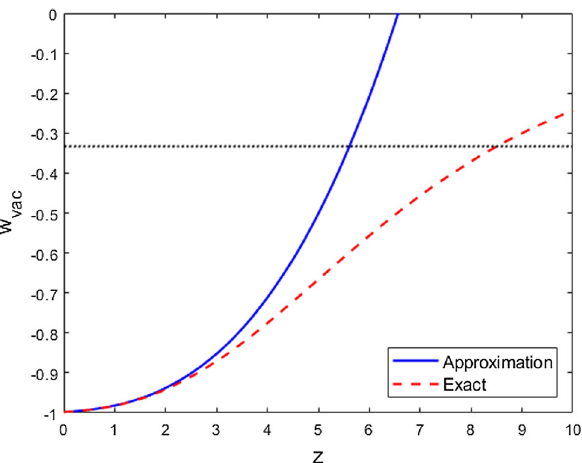
Fig. 3 Vacuum EoS at low redshifts including the quantum effects computed in this work. The horitzontal (dotted) line, marks the constant EoS value − 1/3, below which a fluid contributes to the accelerated expansion. We show both the curve corresponding to the approximate formula (8.16) and the exact curve computed numerically for ν eff = 0 . 005. Because the fitting analyses generally favour the sign ν eff > 0 [78], the EoS deviates slightly from w vac = − 1 already at z = 0 and mimics